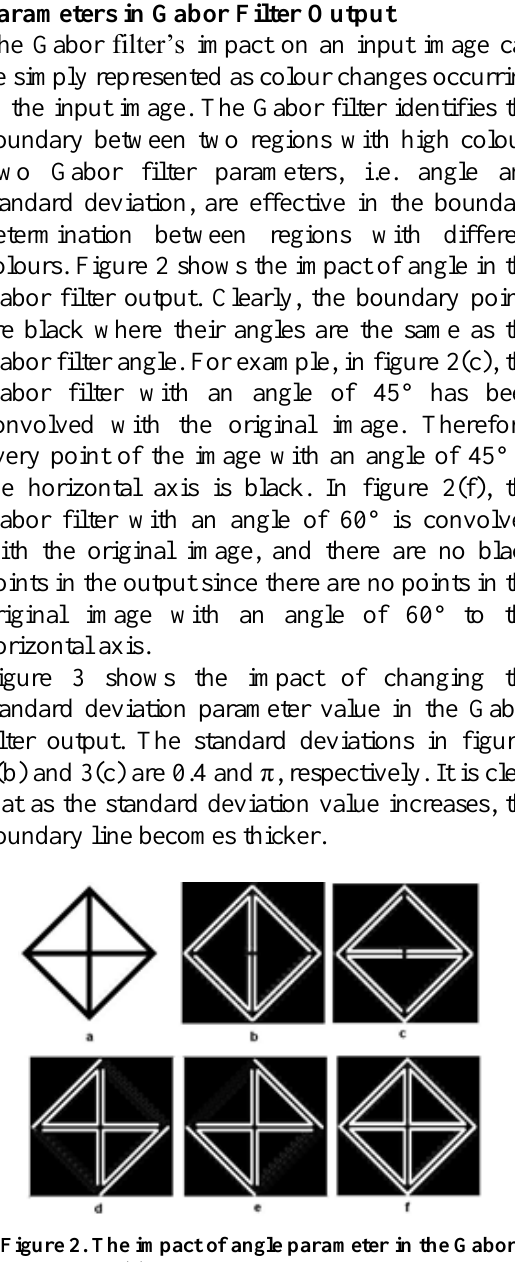
Figure 2. The impact of angle parameter in the Gabor filter output: (a) Original image, the Gabor filter output with the angle value (degrees) of: (b) 0, (c) 90, (d) 45, (e) - 45, and (f) 60. The value of the other Gabor filter generation parameters are as follow: